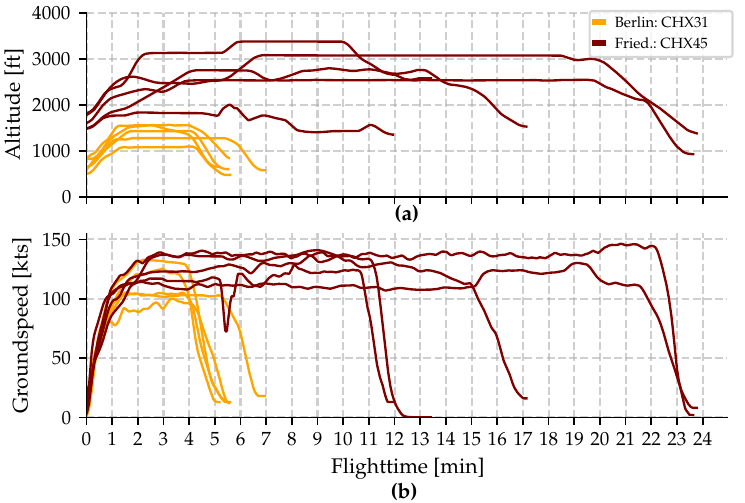
Figure 9. ( a ) Altitude profiles of the five selected flights from station CHX31 and CHX45 . ( b ) The corresponding groundspeed profiles.